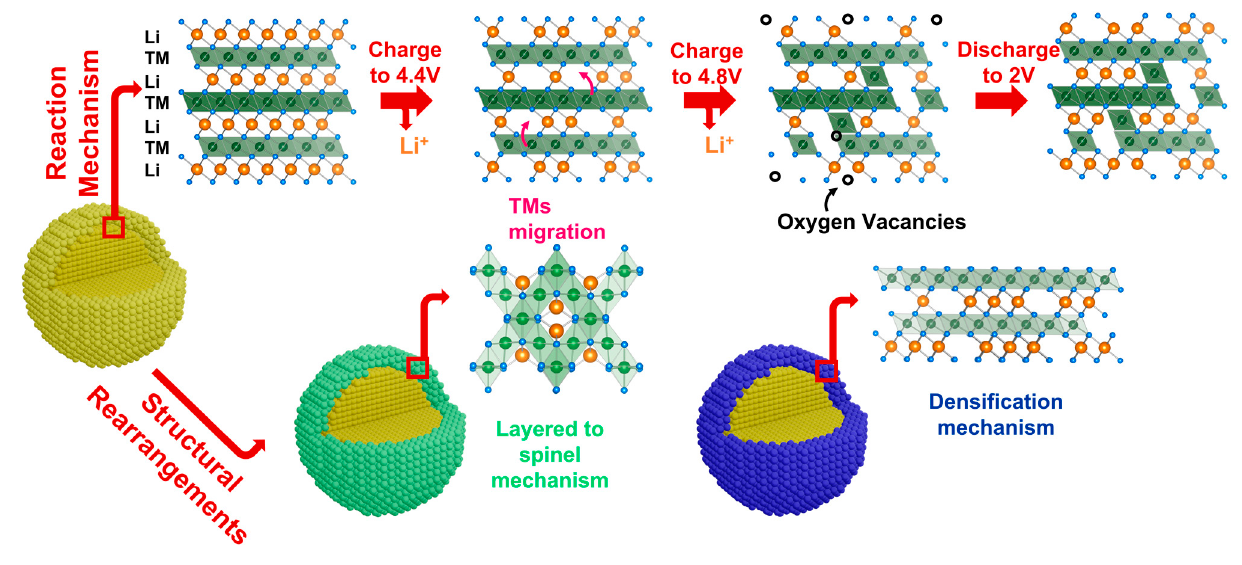
Figure 4. Schematic representation of the reaction mechanism of LRLOs during the electrochemical Li de-intercalation/intercalation and resulting structural changes.